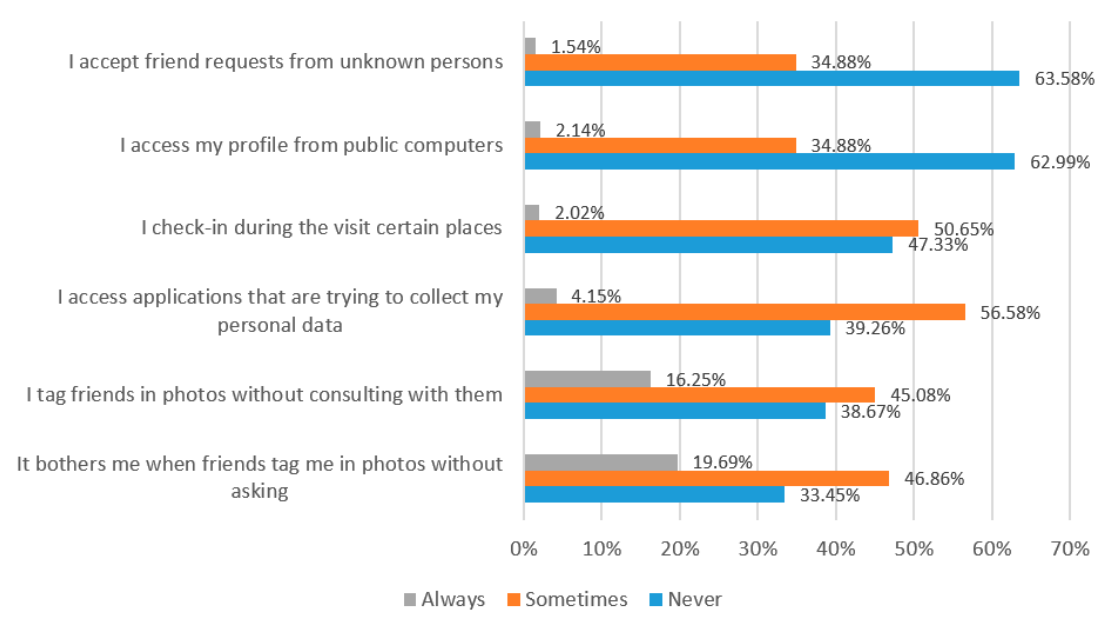
Figure 3. Privacy-related behavior.